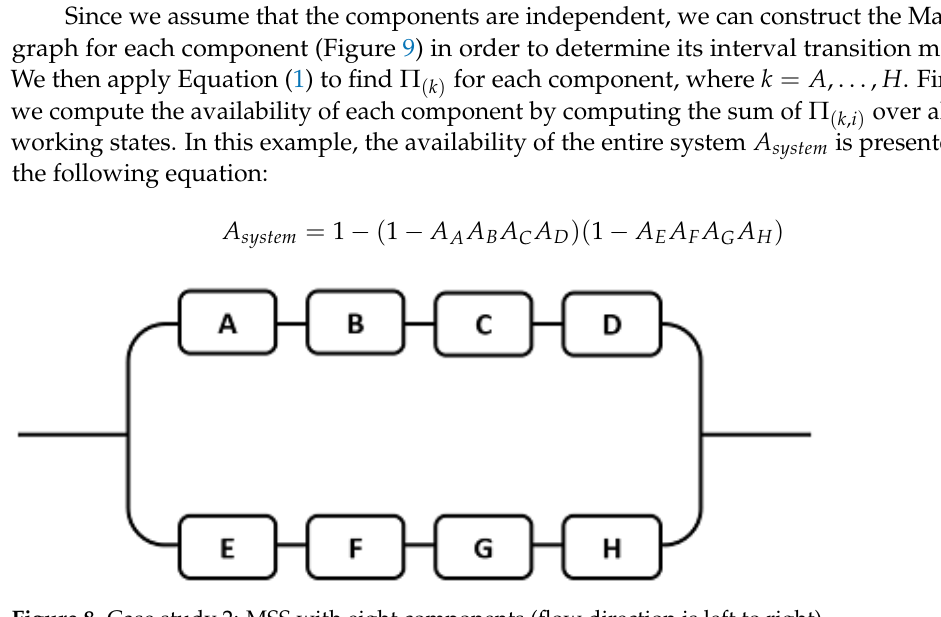
Figure 8. Case study 2: MSS with eight components (flow direction is left to right). Table 8. Failure and repair rates from one state to another for each component. Component Failure Rate Repair